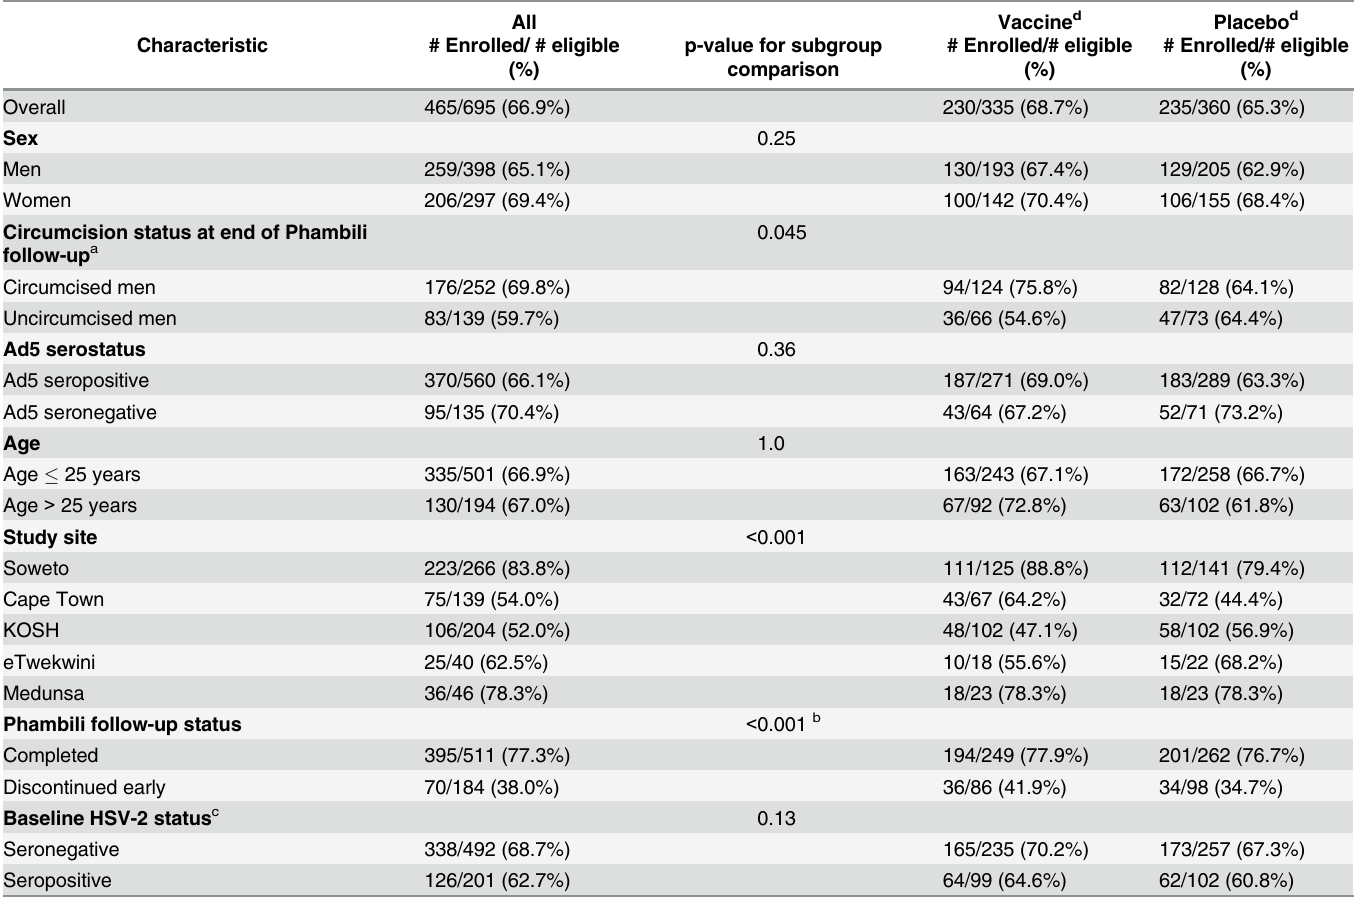
Table 1. HVTN 503-S contact disposition for eligible Phambili participants (N = 695).